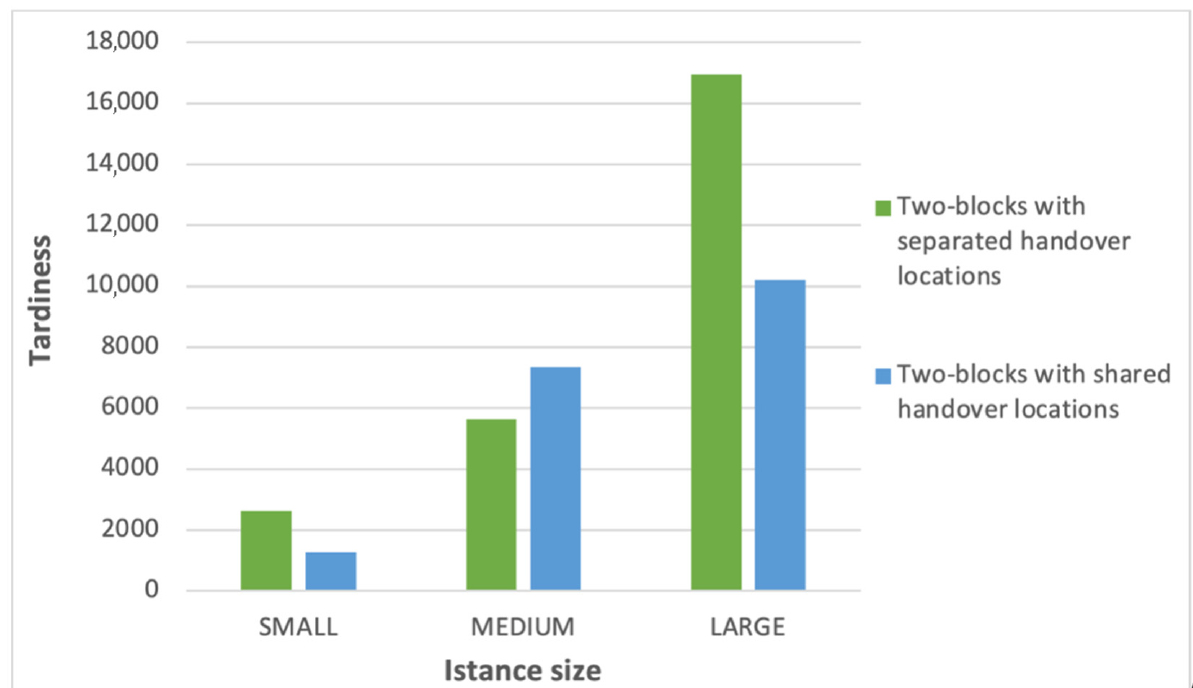
Figure 6. Tardiness values for different layouts and instance sizes.